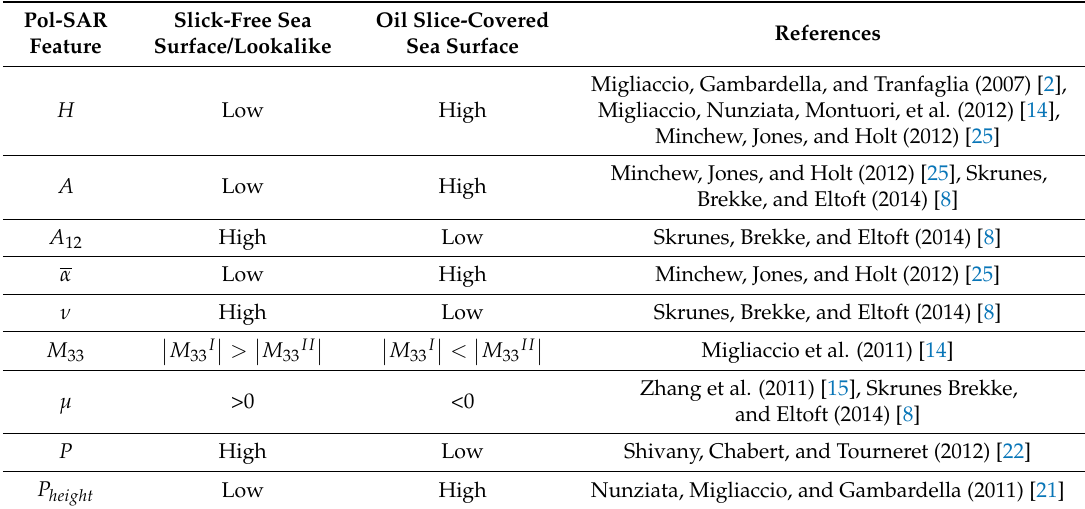
Table 1. Most employed polarimetric features and their expected behavior over sea surface with and without slicks